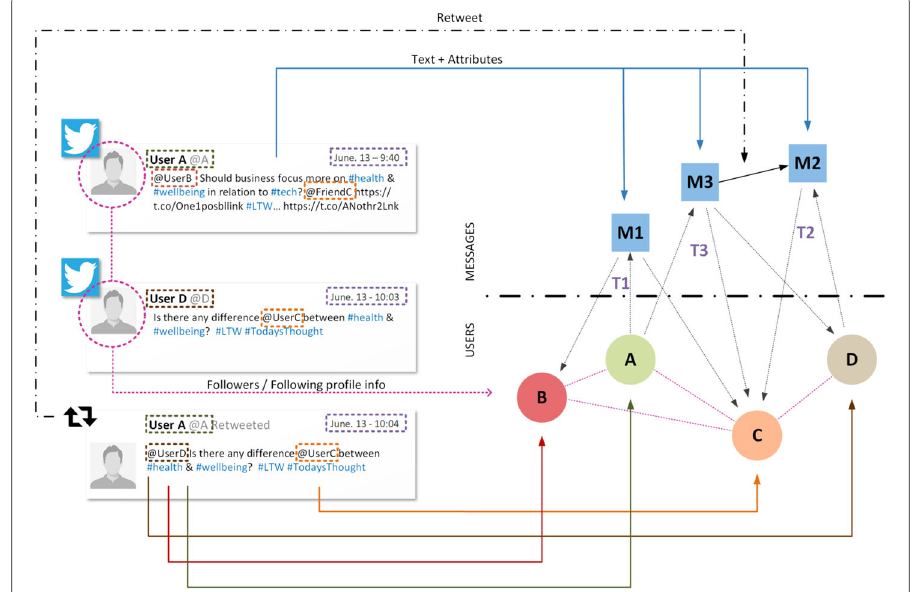
Fig. 6 Model of a Twitter network as a temporal text network. The entire content of each tweet (including hashtags, urls and retweeted content) are encoded as messages. Senders ( @A , @D ) and mentioned users ( @B , @C , @D ) are modeled as individual actors. In this case, both the ingoing and outgoing edges of the message contain the same time, which indicates when the tweet has been sent. The edge between M 3 and M 2 indicates the retweet relation between both